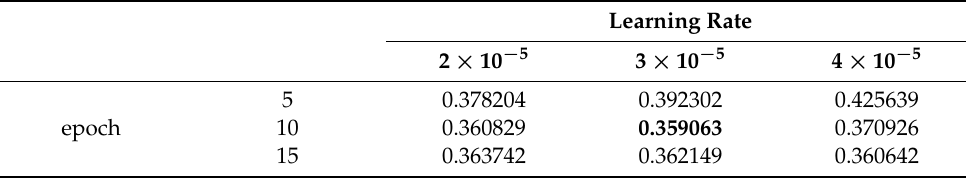
Table 2. Setting different parameters allows the RoBERTa large model to fine-tune the loss rate of the validation set in the CoLA